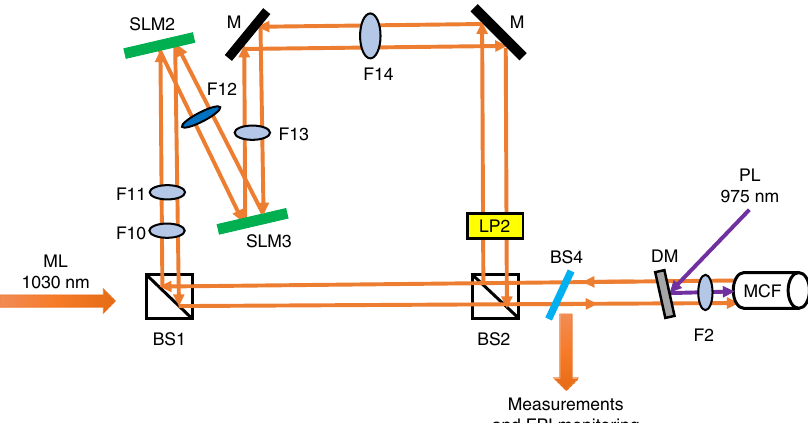
Fig. 5 Programmable optical design for the mutual interaction terms. A nonsymmetric optical design is used to implement J ij elements using two SLMs to control amplitude and connectivity of SLs. All lenses used in this setup are high precision corrected aspheric lens to reduce the aberration